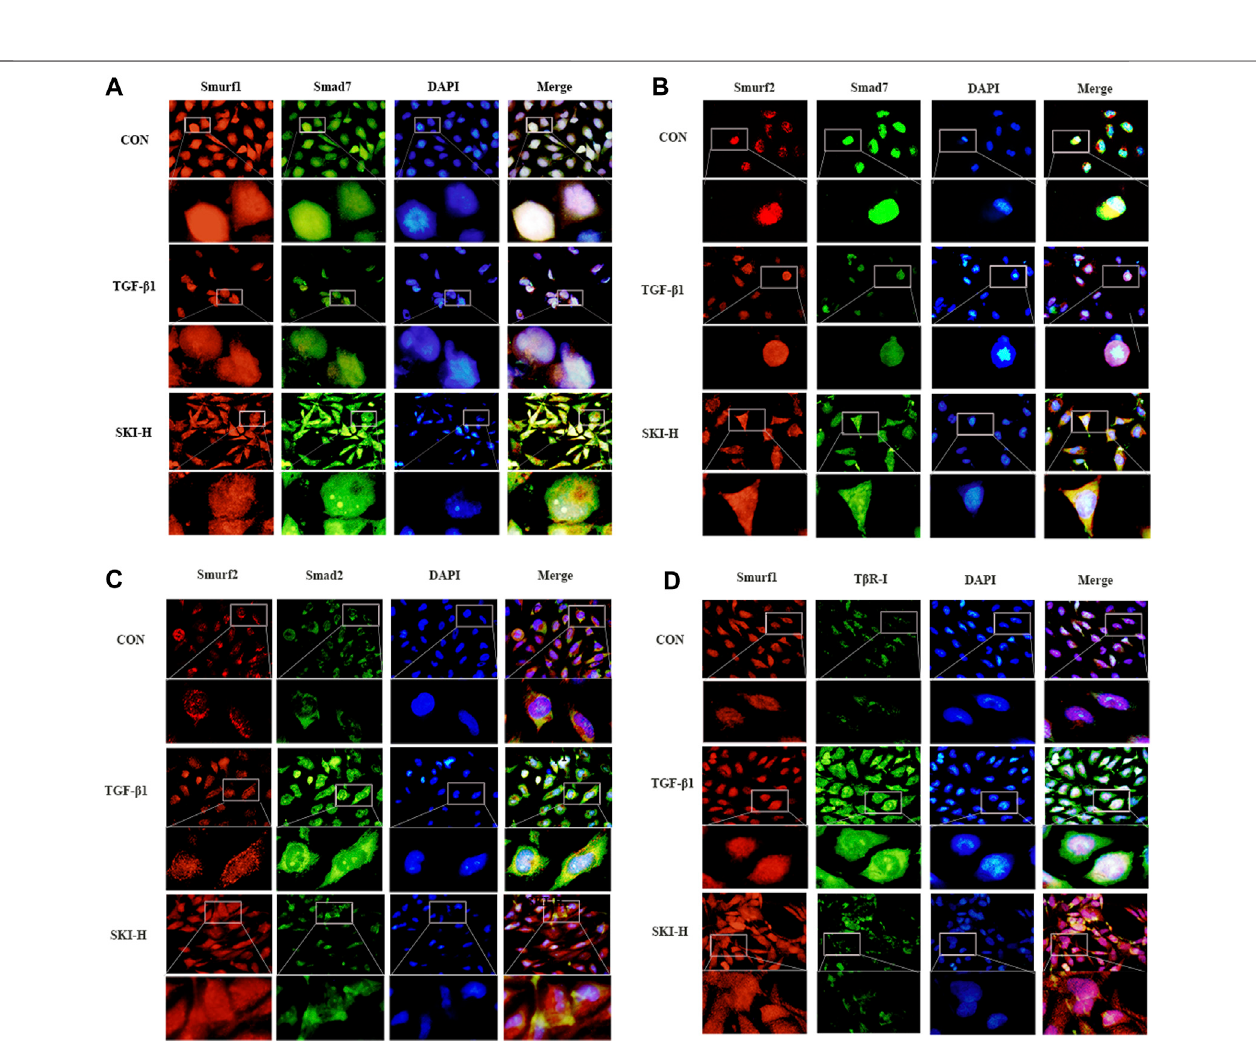
FIGURE 12 | Effects of Shenkang injection on binding and translocation of Smurf1/2 to Smad7, Smad2, and T β R-I. (A) Immuno fl uorescence method was used to detect the localization of Smurf1 (red) and Smad7 (green) proteins in HK-2 cells and the expression of fl uorescence intensity and DAPI staining nuclei (blue). (B) Immuno fl uorescence method was used to detect the localization of Smurf2 (red) and Smad7 (green) proteins in HK-2 cells and the expression of fl uorescence intensity And DAPI staining nuclei (blue). (C) Immuno fl uorescence method was used to detect the localization of Smurf2 (red) and Smad2 (green) proteins in HK-2 cells and theexpressionof fl uorescenceintensityAndDAPIstainingnuclei(blue). (D) ThelocalizationofSmurf1(red)andT β R-I(green)proteinsinHK-2cellsandtheexpressionof fl uorescence intensity were detected by immuno fl uorescence, and the nuclei were stained with DAPI (blue). Frontiers in Pharmacology |